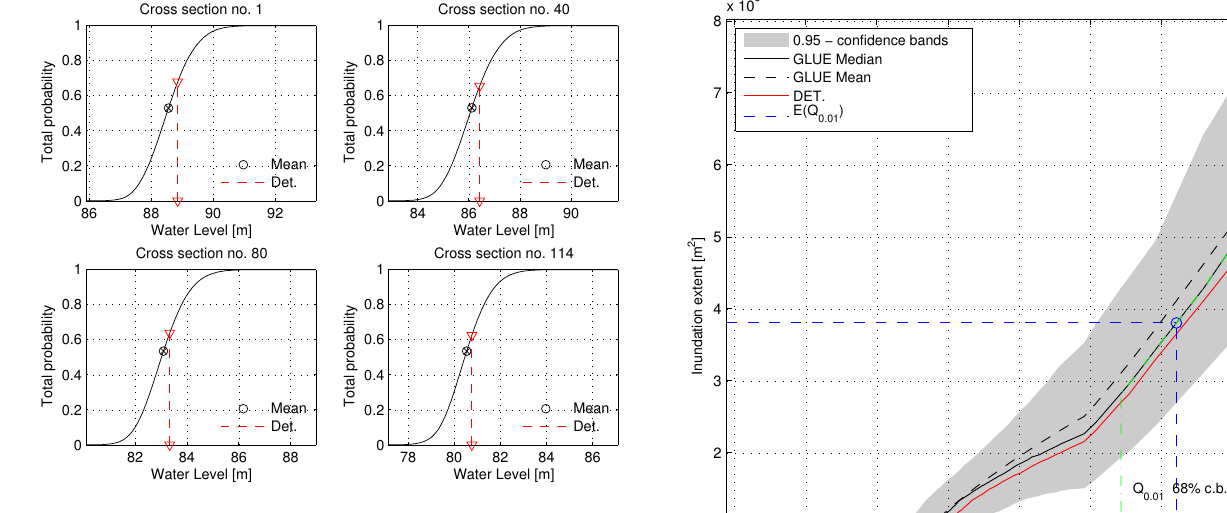
Fig. 9. Relationship between the inundation extent and the input flow rate for the ZOO area. Continuous red line denotes the deter- ministic solution, black continuous line denotes the median, black dashed line denotes the mean and gray shaded area denotes 0.95 Fig. 7. The map of the probability of inundation extent for the ZOO confidence bands; blue dashed lines show a 1-in-100 yr flow and area with superimposed deterministic boundaries. corresponding inundation extent value; green dashed lines denote 0.68 confidence limits.